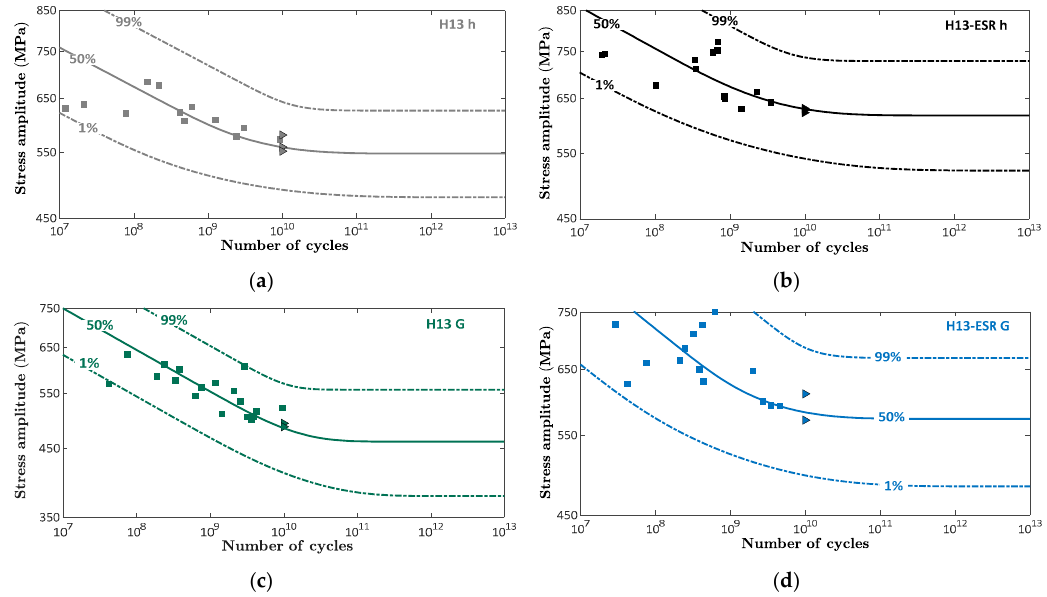
Figure 7. Marginal P–S–N curve: ( a ) H13 hourglass, ( b ) H13-ESR hourglass, ( c ) H13 Gaussian, ( d ) H13-ESR Gaussian.